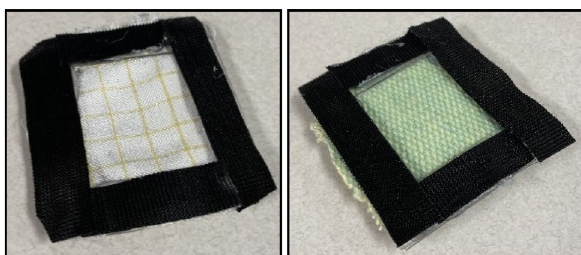
Figure 6. Orthofabric (left) and Kevlar (right) Fabric